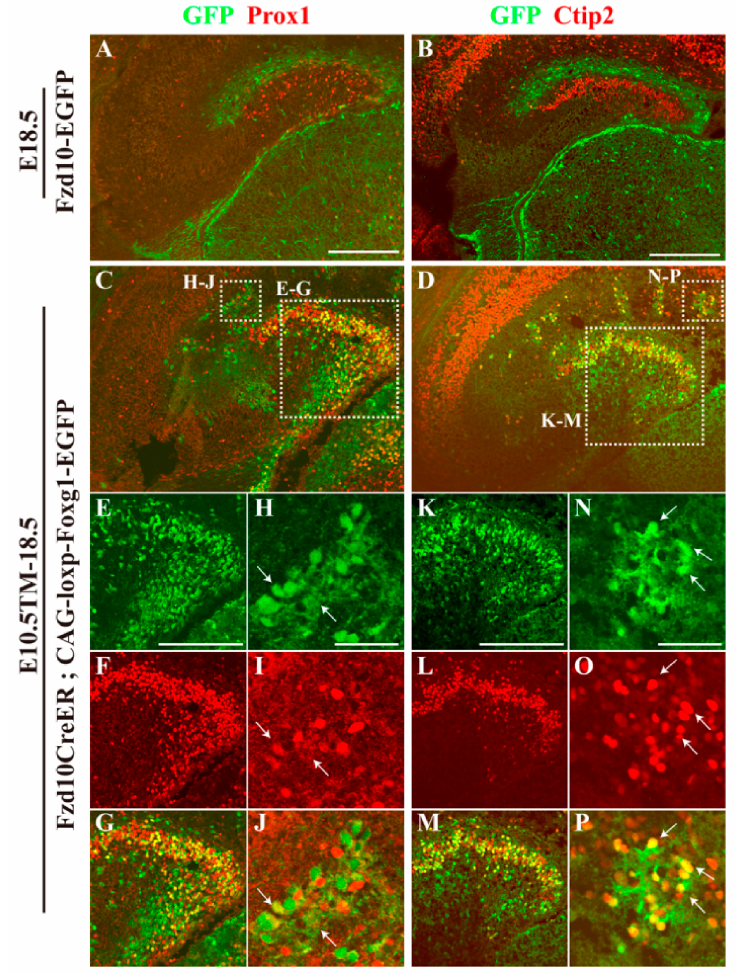
Figure 3. Hem-derived CR cells switched their fates into dentate granule neurons. ( A , B ) Double immunofluorescence analysis of GFP and Prox1 ( A ), Ctip2 ( B ) on coronal brain sections of Fzd10-EGFP embryos at E18.5. Hem-derived GFP cells are negative for Prox1 and Ctip2. ( C , D ) Confocal images of immunofluorescence of GFP and Prox1 ( C ), Ctip2 ( D ) on coronal E18.5 brain sections when TM was administered at E10.5. The ectopically-located hem-derived cells within the DG transformed to the granule neurons. ( E – P ) Magnified views of boxed areas in ( C , D ). Arrows in ( I , J ) indicate the GFP + ; Prox1 + cells, arrows in ( O , P ) indicate the GFP + ;Ctip2 + cells. Scale bars: ( A – D ) 200 µ m; ( E – P ) 50 µ